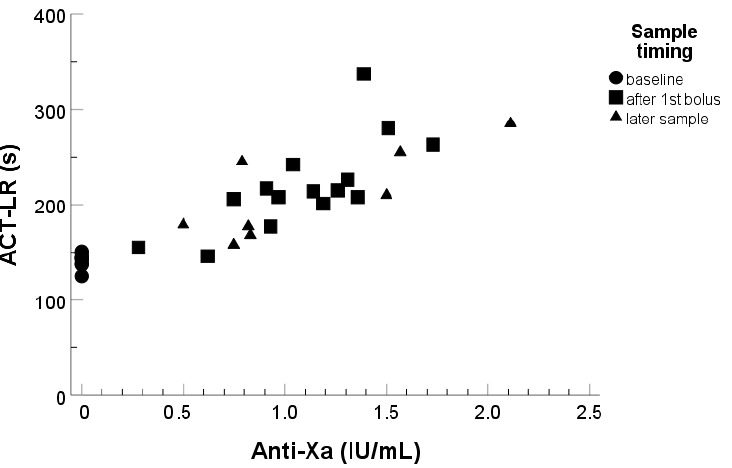
Figure 1. Correlation between activated clotting time (ACT, Hemochron ® ) and UFH level measured with anti-FXa (IL ® ), n = 32 different measurement points in 15 patients after IV heparin treatment undergoing peripheral arterial angiographic procedure. Correlation with low-range ACT-LR mea- surement, R 2 = 0.73. Correlation with high-range ACT+-measurement, R 2 =